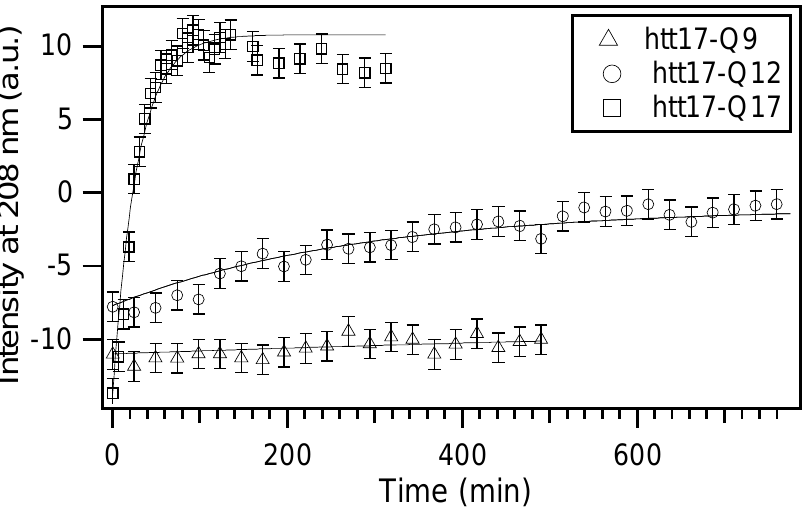
Figure 2. Aggregation kinetics by circular dichroism: the time-dependent intensity of the CD signal measured at 208 nm is shown for htt17-Q9, htt17-Q12, and htt17-Q17 in the presence of 0.45 mg/mL SUVs made of POPC/POPS 3/1 mole/mole in 10 mM Tris-HCl, pH 7. The results of least square fits with a mono-exponential function are displayed as solid lines. An error of ±1 was estimated from the signal-to-noise ratio of the spectra.